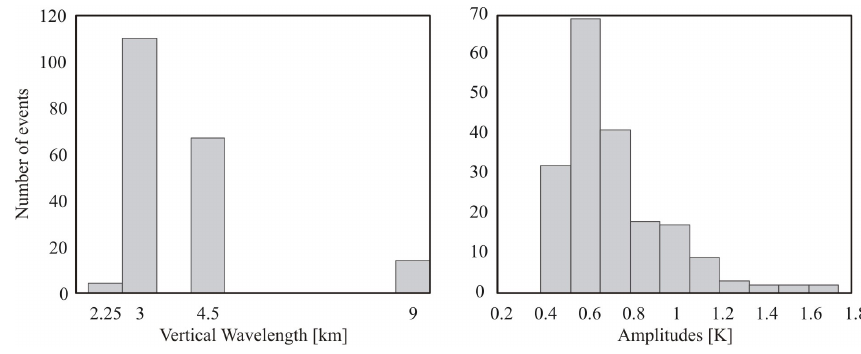
Fig. 8. Vertical wavelength and amplitude distribution for cases with E p >